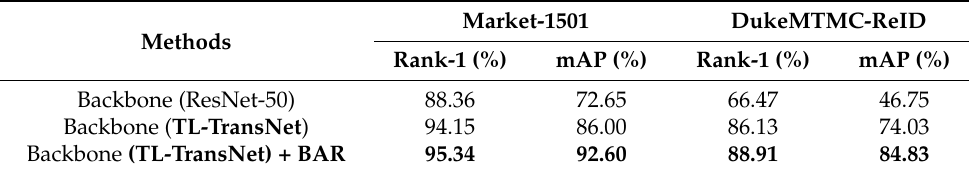
Table 2. Ablation studies of the proposed method on individual components.